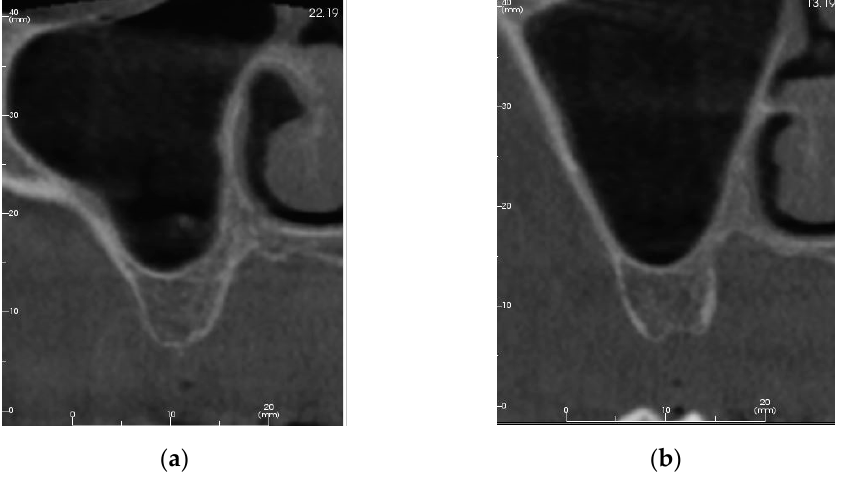
Figure 1. Patient #1. Preoperative CBCT cross-section images of the surgical sites showed: ( a ) first molar area: adequate ridge width and 6.8 mm available bone height; ( b ) second molar area: adequate ridge width and 6.4 mm available bone height. Schneiderian membrane showed no signs of hyper- trophy or inflammation.